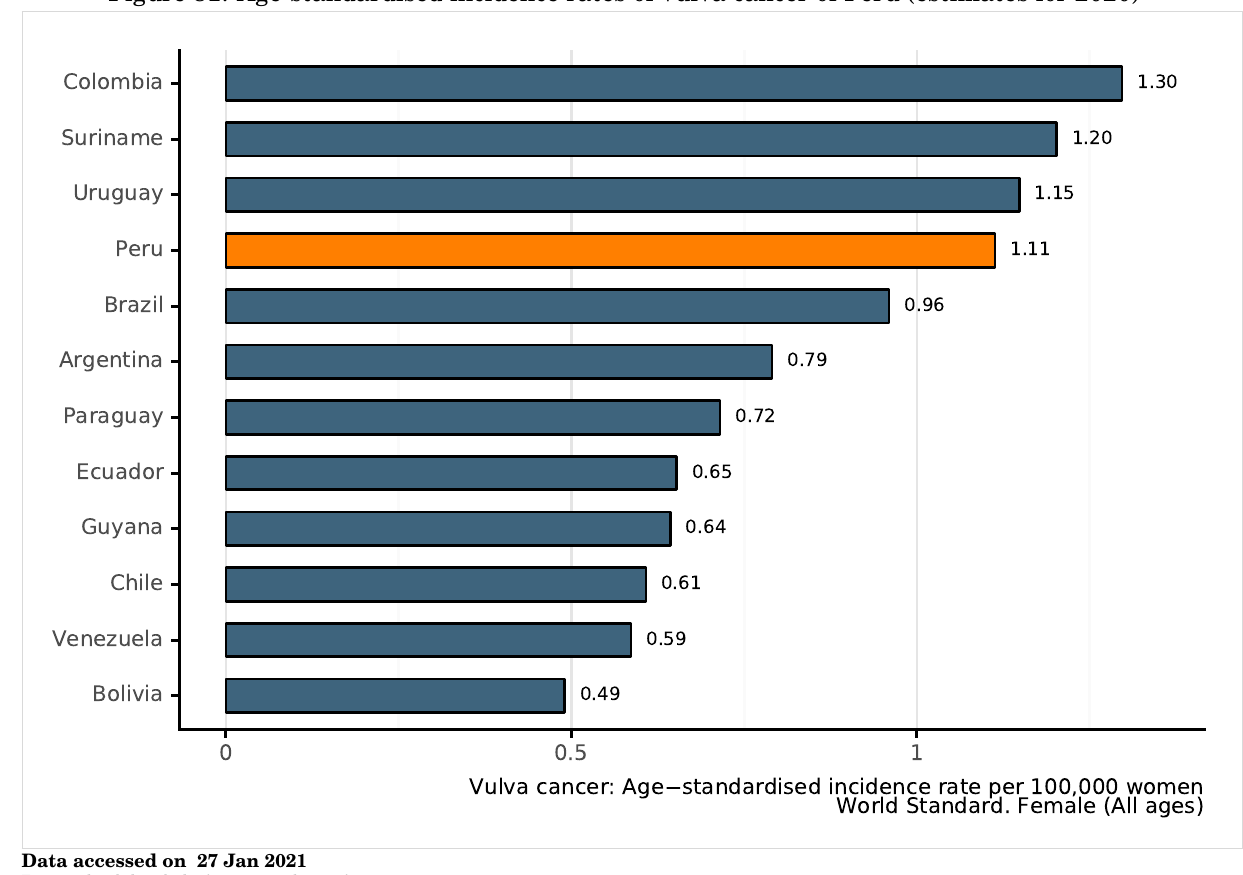
Figure 81: Age-standardised incidence rates of vulva cancer of Peru (estimates for 2020)